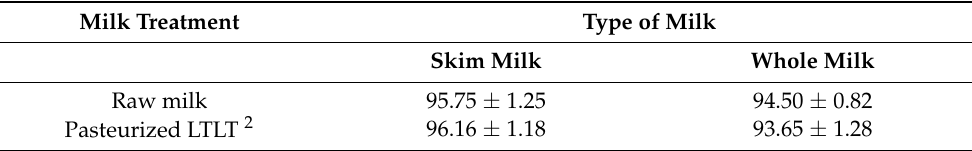
Table 2. Stability of fucoxanthin based on percent recovery 1 after heat of pasteurization in goat whole and skim milk.